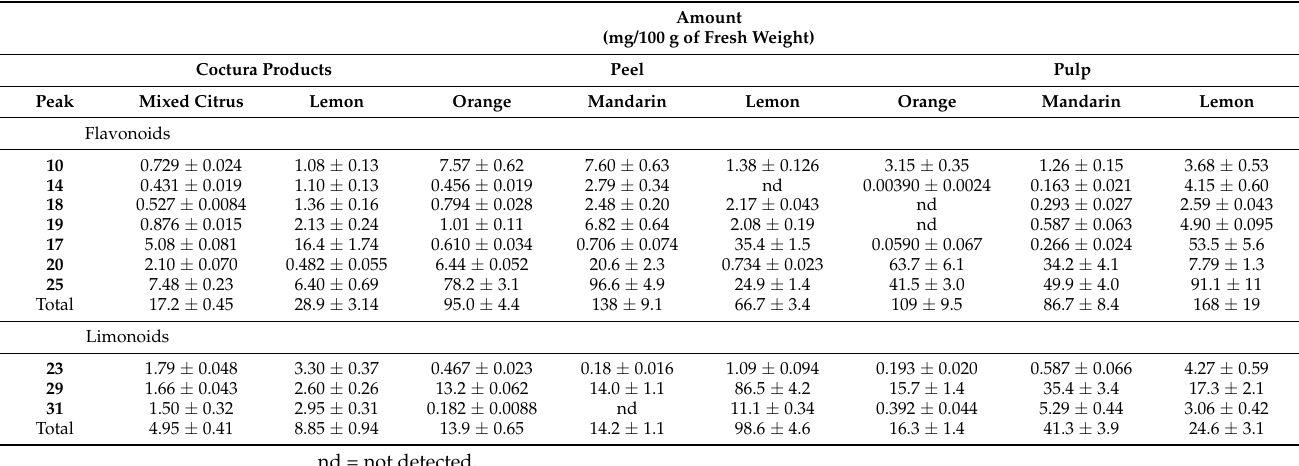
Table 5. Amount of flavonoids and limonoids in Coctura ® products and fresh Citrus samples expressed as mg/100 g of fresh product.